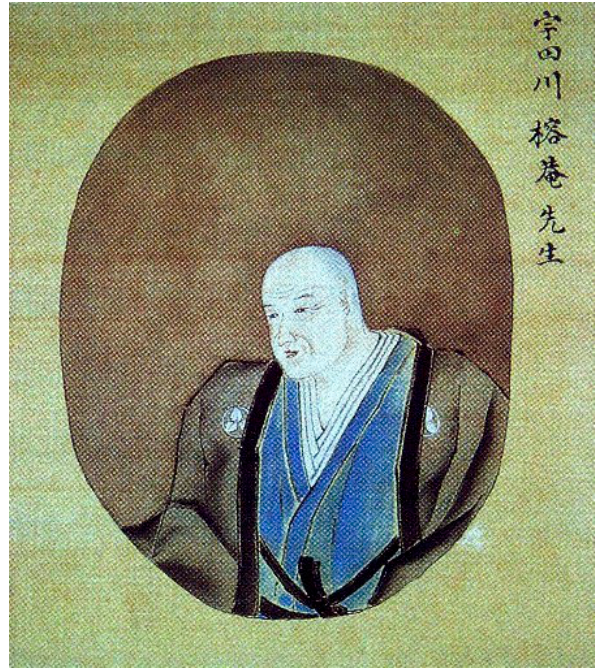
Figure 1. Scholar Udagawa